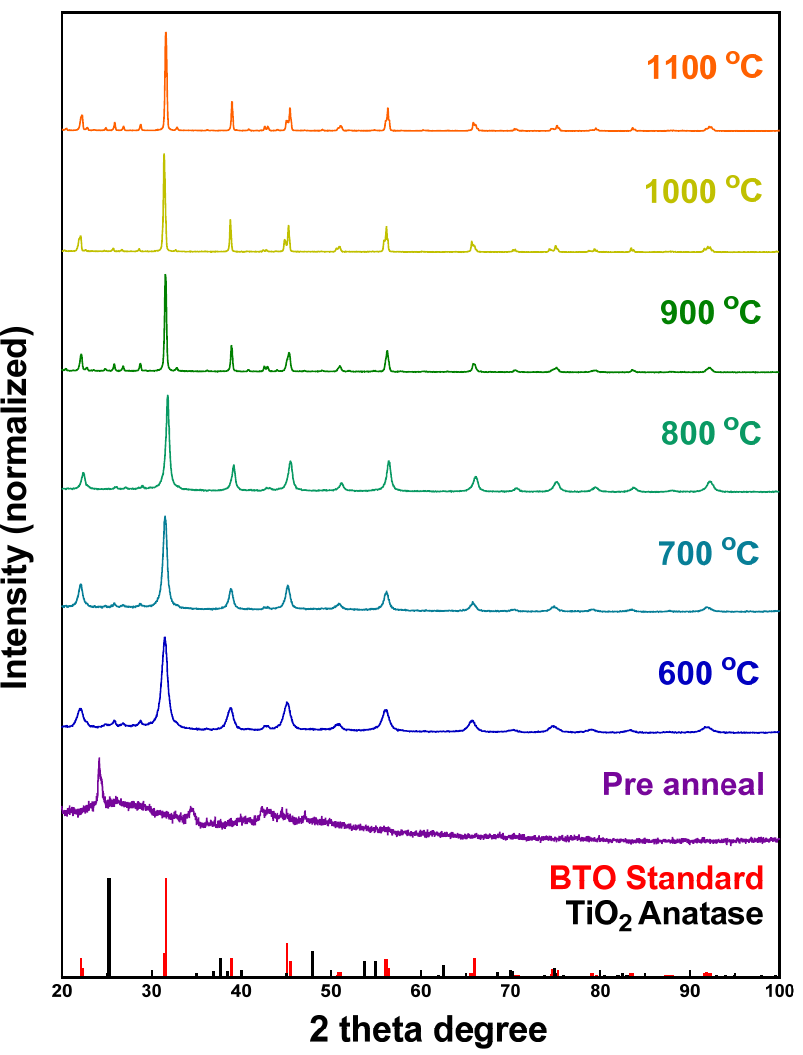
Figure 4. XRD patterns of a BTO powder sample calcined from 600 ◦ C to 1100 ◦ C, in increments of 100 ◦ C. The data on all samples were acquired after the acid wash, except for the pre-annealed sample. Samples are compared with standard anatase TiO 2 and BTO patterns.